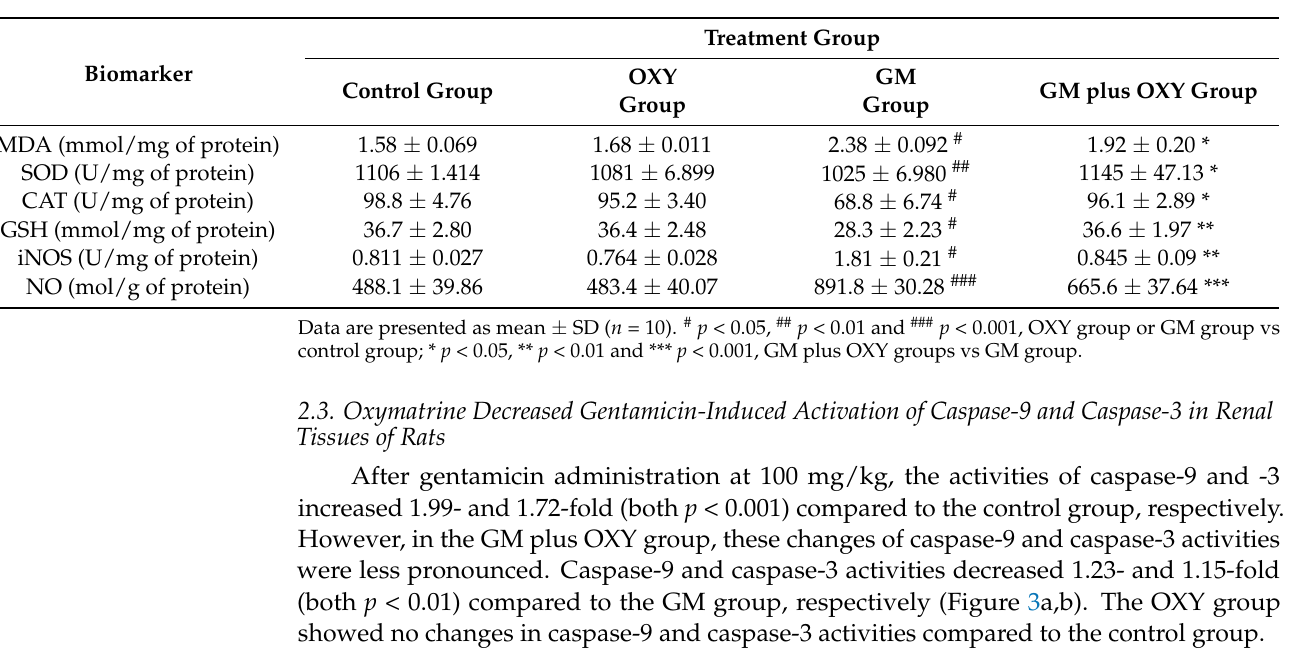
Table 1. Effect of oxymatrine pre-treatment on the levels of oxidative and nitrative stress markers in the renal tissues of rats treated with gentamicin.